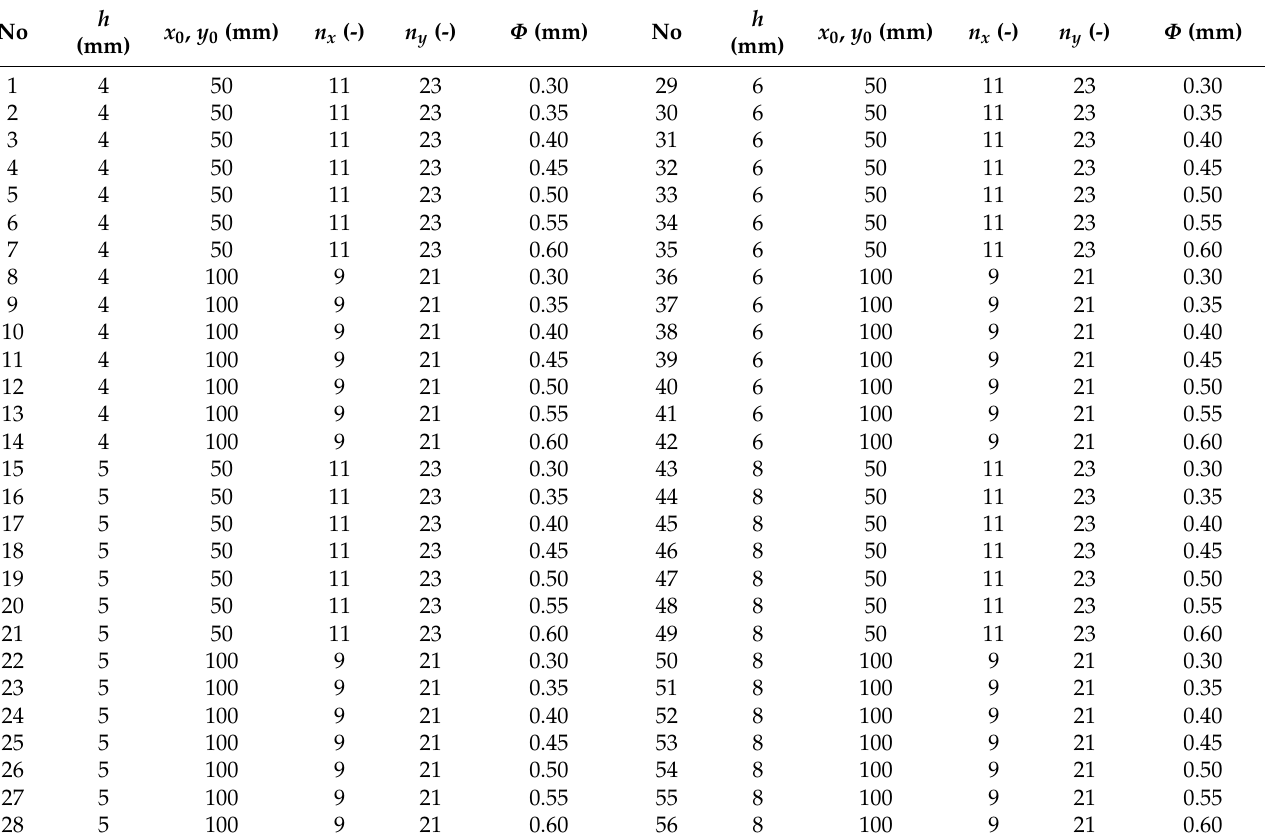
Table 1. Variable parameters in the first category of analysis—geometrical parameters.